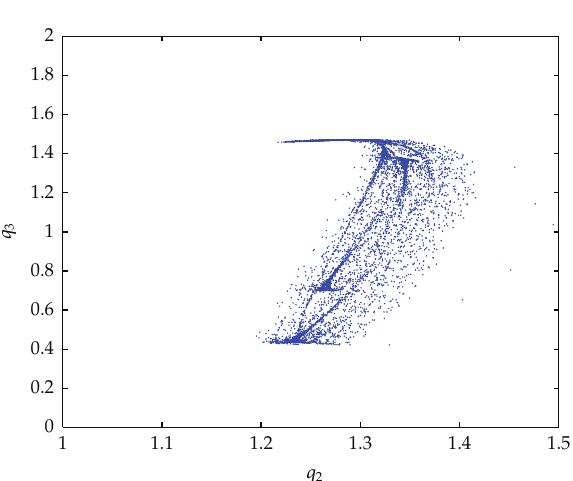
Figure 11: Strange attractor when β (cid:7) 0 . 2 ,α (cid:7) 23 . 1.